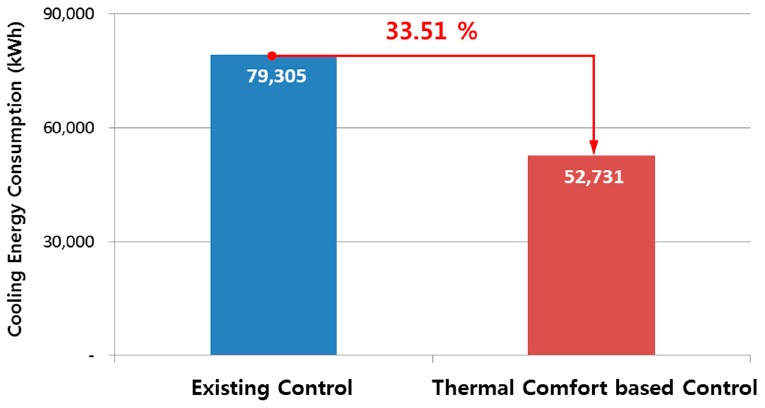
Figure 6. Cooling energy consumption depending on the temperature control method.